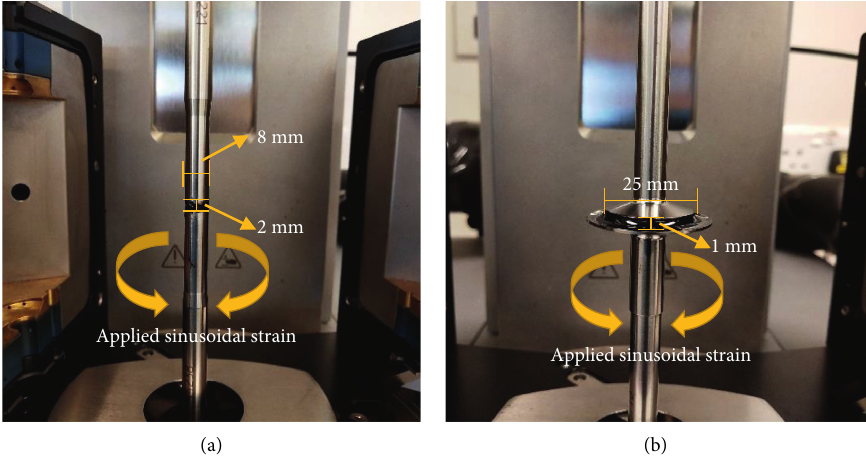
Figure 3: DSR measuring system used for (a) asphalt binder (8mm plates) and (b) asphalt mastic (25 mm